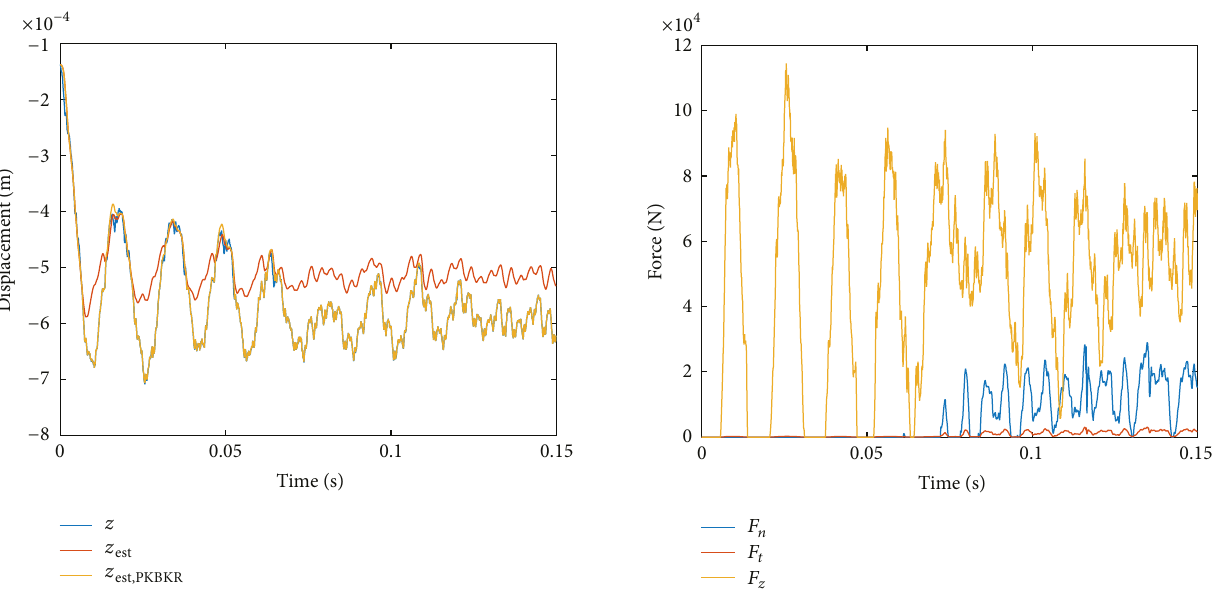
Figure 6: Estimated force. Experiment